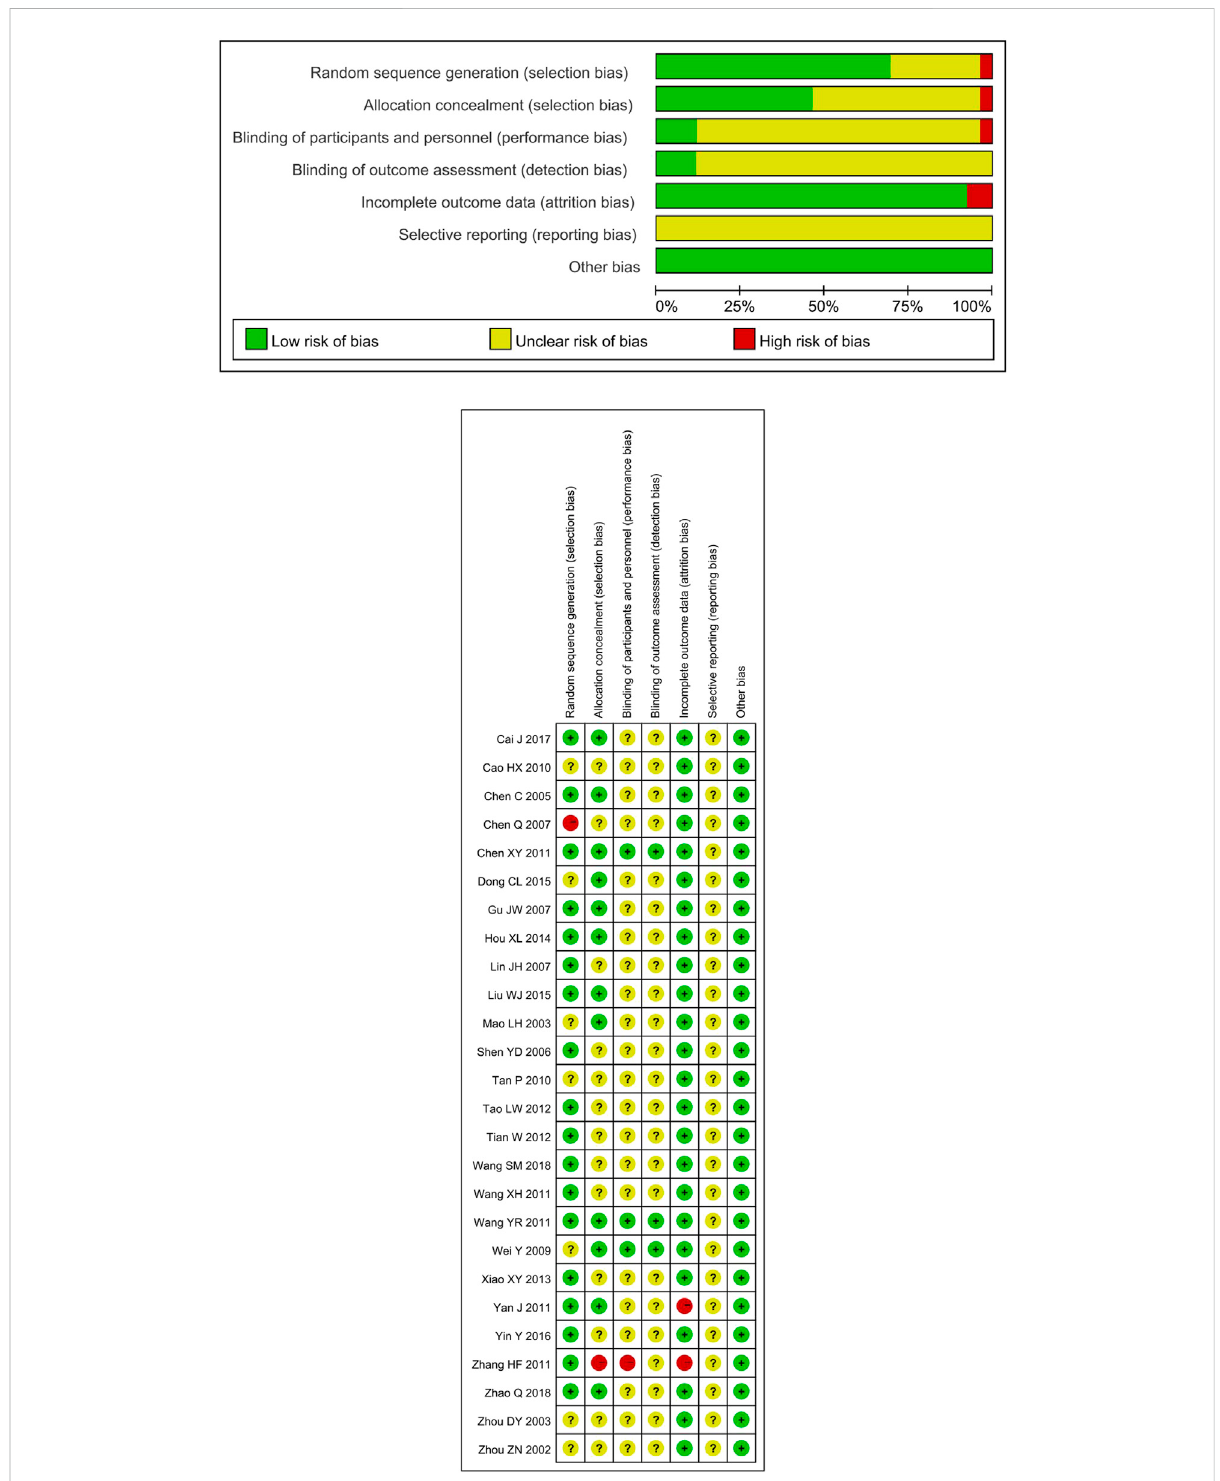
FIGURE 2 Risk of